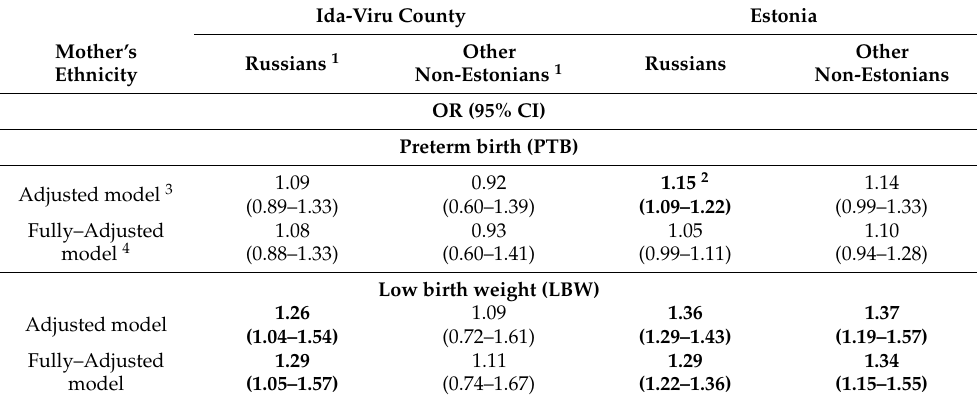
Table 4. Associations between adverse birth outcomes and mother’s